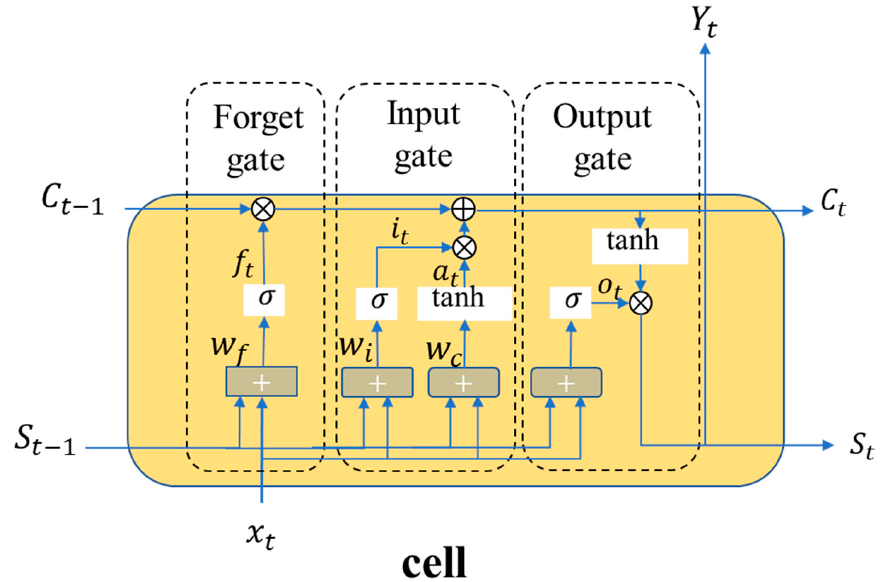
Figure 9. Structure diagram of a long short-term memory neural network model.